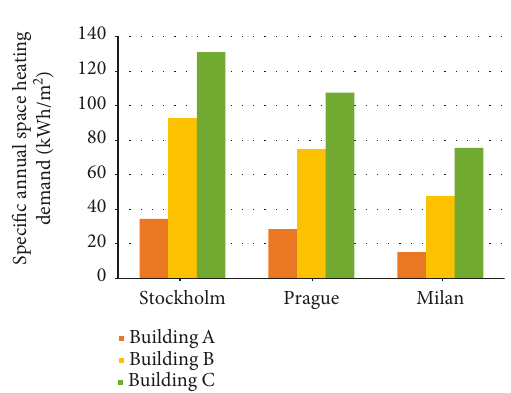
Figure 9: Speci fi c space heating demand for buildings and